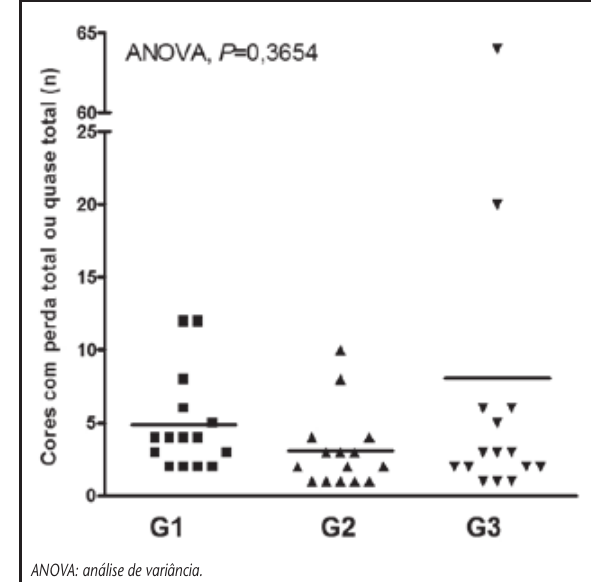
ANOVA: análise de